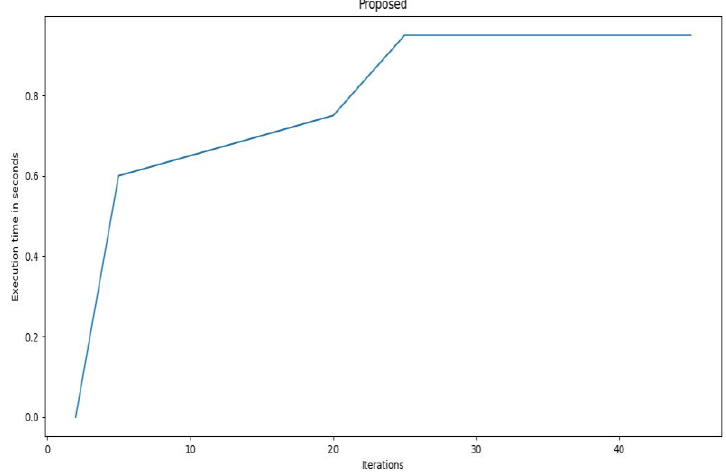
Figure 3. The iteration process about the execution time.